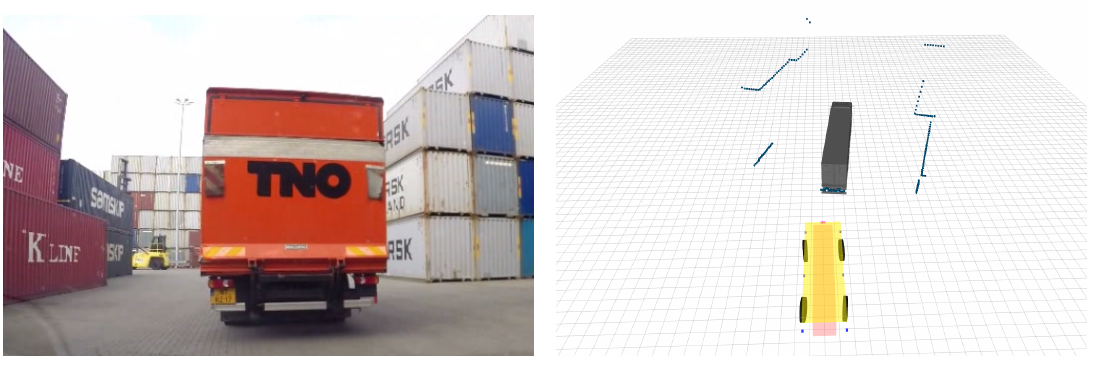
Figure 14. Real experimental sequence. Left, we show a snapshot of the sequence captured in the real port environment where the truck to be followed is appreciated. Right, we show the corresponding visualization of the 2D-LRF measurements obtained, along with the ground-truth of the